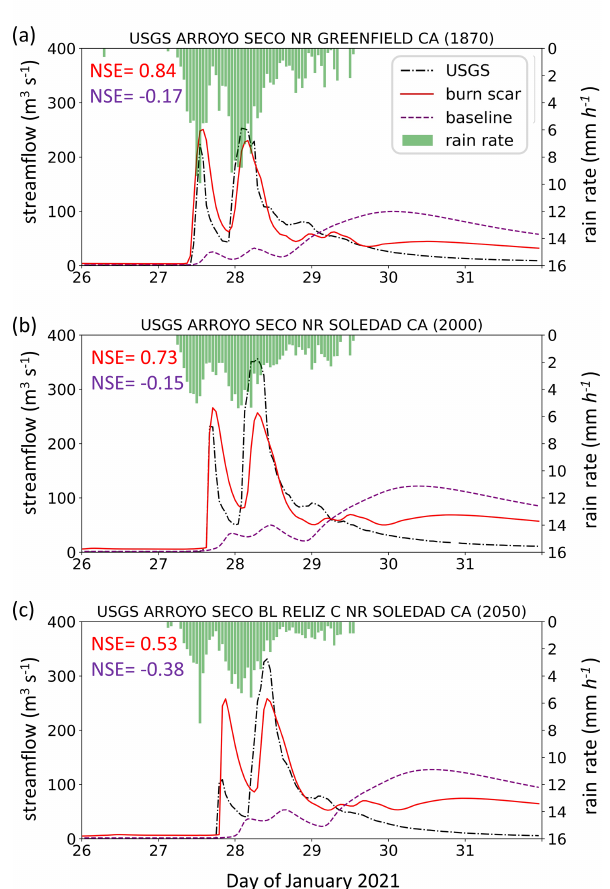
Figure 6. Precipitation and observed and simulated streamflow at three USGS stream gages. MRMS precipitation from 26–31 Jan- uary 2021 (mmh − 1 ; green bars) and observed (m 3 s − 1 ; dash- dotted black line) and simulated streamflow in baseline simulation (m 3 s − 1 ; dashed purple line) and burn scar simulation (m 3 s − 1 ; red line) at (a) Arroyo Seco NR Greenfield, CA (ID 11151870), (b) Ar- royo Seco NR Soledad, CA (ID 11152000), and (c) Arroyo Seco BL Reliz C NR Soledad, CA (ID 11152050). NSE scores for baseline (purple) and burn scar simulations (red) are shown at the top